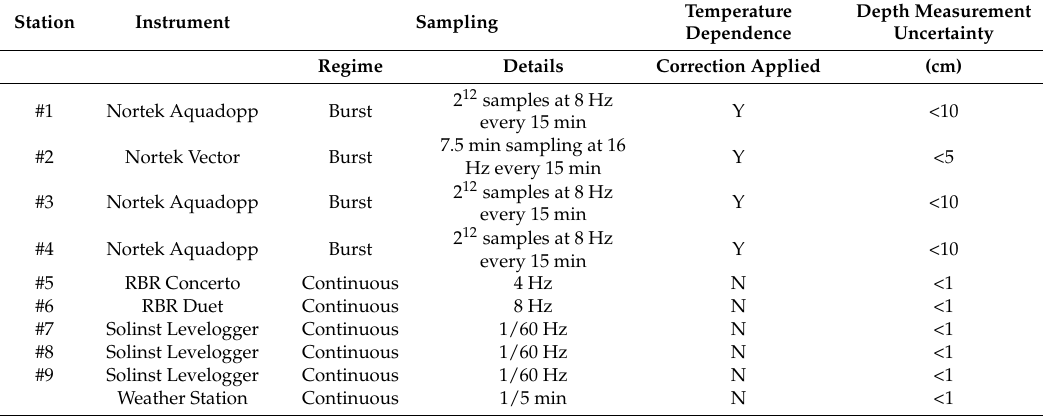
Table 1. The Firth of Thames instrument array. Note that during factory calibration, the Aquadopp depth uncertainty over the range of interest was <5 cm and the Vector uncertainty was <2 cm.